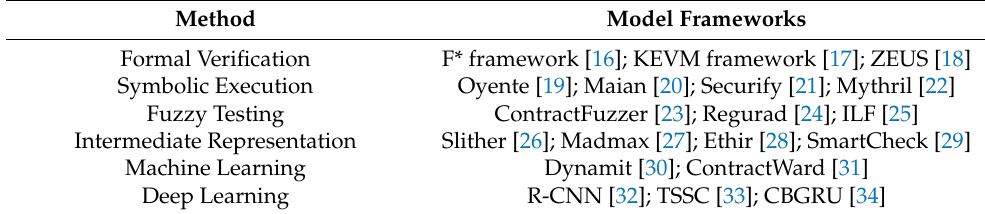
Table 1. Existing smart contract vulnerability detection